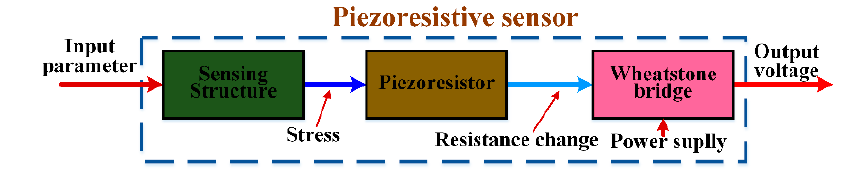
Figure 2. Basic principle for piezoresistive sensors.